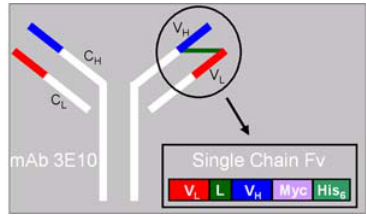
FIGURE 1. The single-chain Fv fragment of mAb 3E10. A transducible single-chain Fv fragment of mAb 3E10 was generated by cross-linking the variable regions of the antibody’s light (V L ) and heavy (V H ) chains. A myc tag was added to aid in detection of the Fv fragment and a histidine tag was added for purification of the Fv fragment and Fv- fusion proteins. (L = [GGGGS] 3 linking sequence, C H = constant region of mAb 3E10 heavy chain, C L = constant region of mAb 3E10 light